Question: Express in one sentence what the figure is showing.
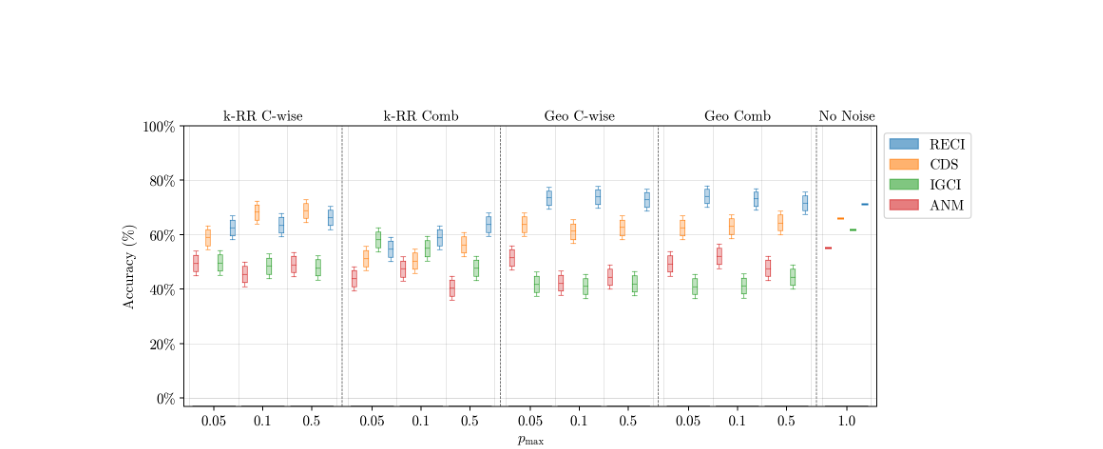
Answer: CEP data set with 2 nodes, weighted accuracy. Box whiskers are at 95%, body is at 80% confidence.